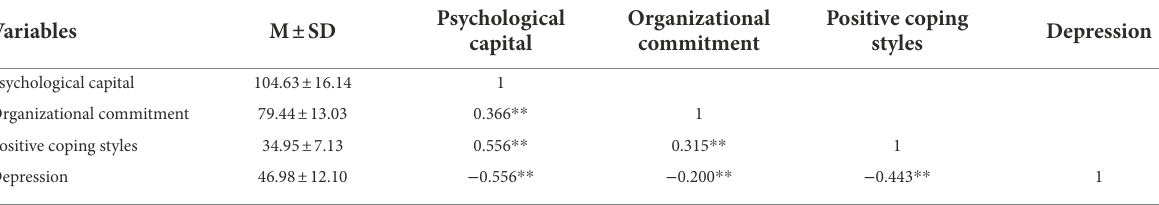
TABLE 2 Correlations between psychological capital, organizational commitment, positive coping styles and depression.